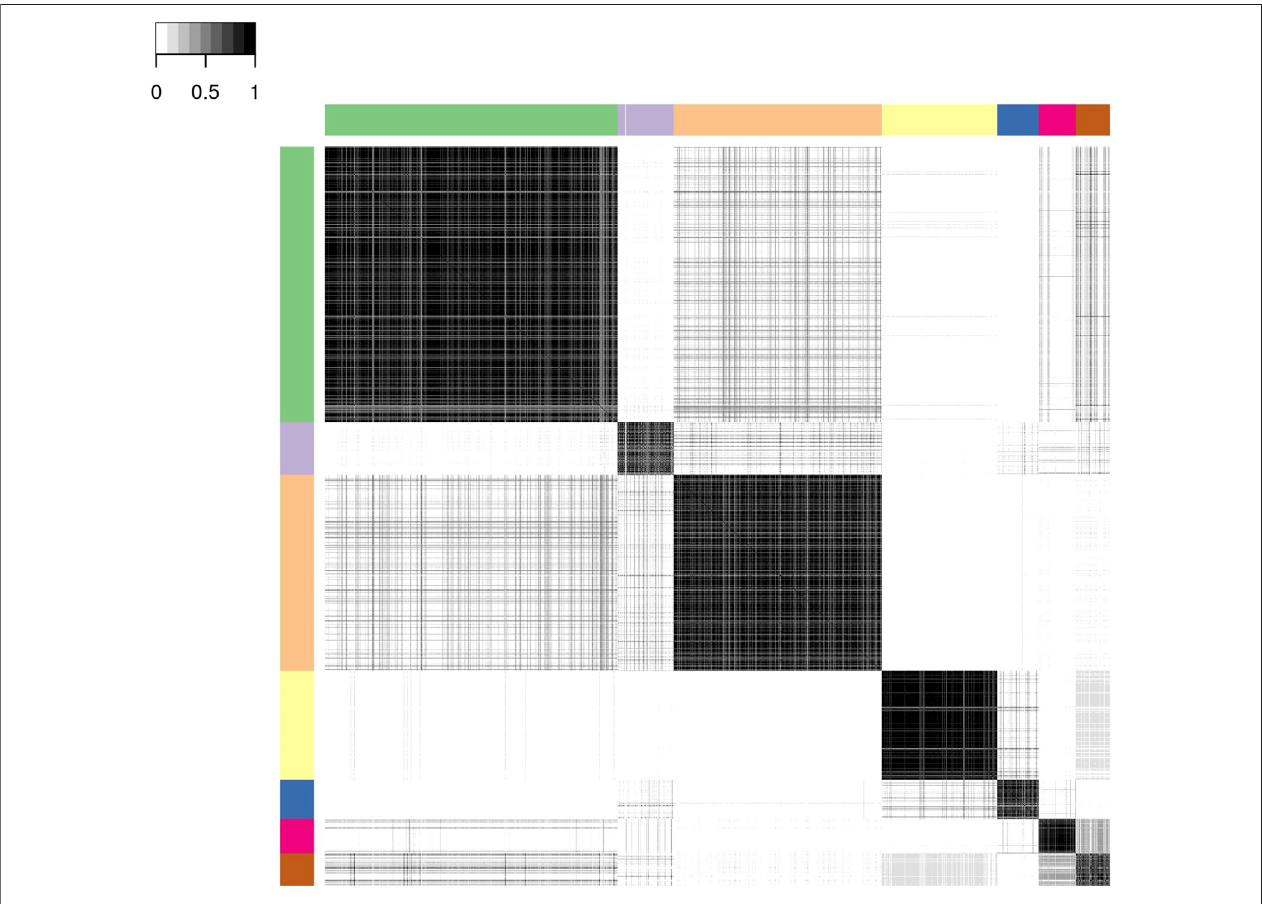
FIGURE3| PosteriorsimilaritymatrixfortheconsensusacrossthesixMCMCchainsfromtheBayesianpro fi leregressionanalysisonthe1,543EPADparticipants. Eachentry( i , j )ofthis1,543 × 1,543-matrixrepresentstheproportionoftimesparticipants i and j areassignedtothesameclusteroverthe250,000 × 6MCMCiterations. Color bars indicate the seven fi nal PAM consensus representative clusters of participants identi fi ed. See Figure 4 for more information regarding these clusters.